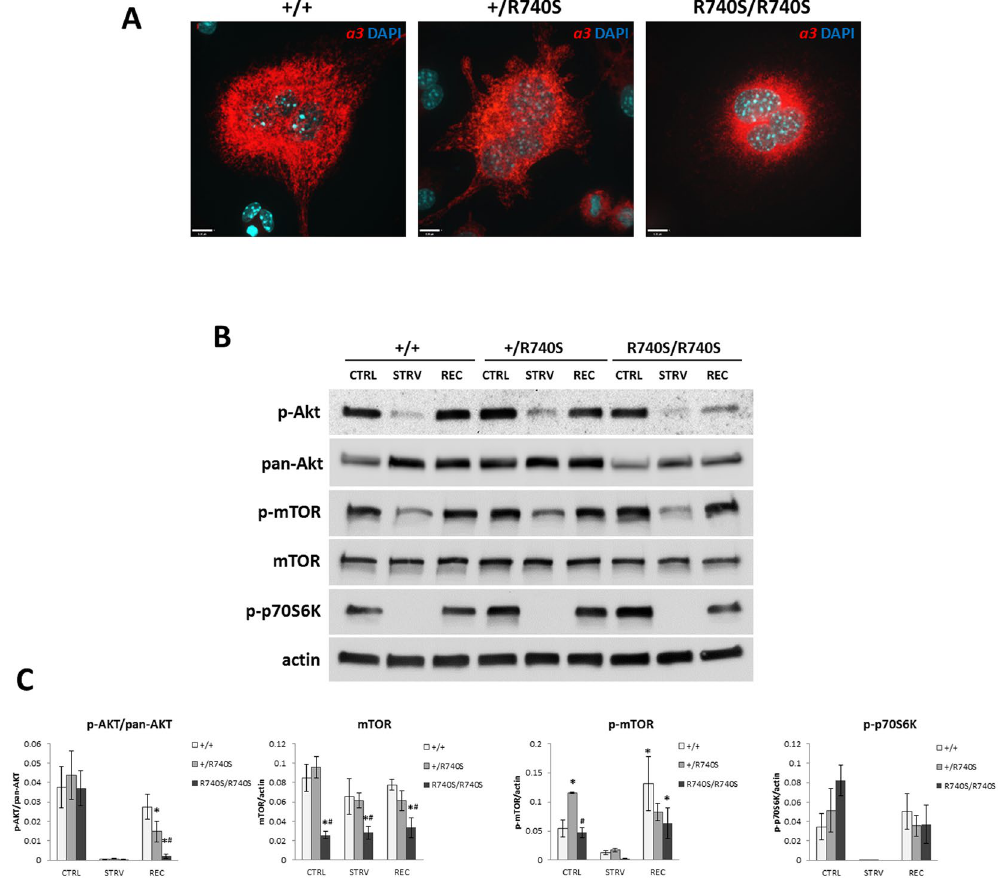
Figure 1. mTORC1 activity is increased in R740S/R740S cells. Spleen-derived osteoclasts were differentiated as described in “Materials and Methods”. On day 4 of culture, the cells were incubated with HBSS (starvation) for 60 min, and then in fully supplemented media for additional 30 min. ( A ) Immunofluorescence. Cells were fixed and stained with an anti- a 3 antibody as described in “Materials and Methods”; nuclei were stained with DAPI. Representative images of three independent experiments. Bars, 15 μ m. ( B ) Immunoblotting, representative cropped blots of 4 independent experiments. Whole cell lysates were separated on 4–20% gradient gels, transferred to a nitrocellulose membrane and probed for mTOR, p-mTOR, p-AKT, pan-AKT, p-p70S6K, and actin. (C) Quantification of immunoblots; combined normalized data of at least 4 independent experiments, mean ± std. dev; * indicates statistical significance compared to + / + control, # indicates statistical significance compared to + /R740S control, p <